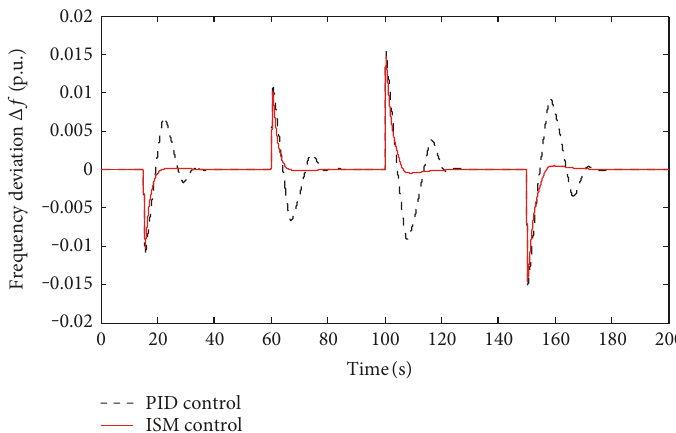
Figure 6: The frequency deviation with power output constraints.